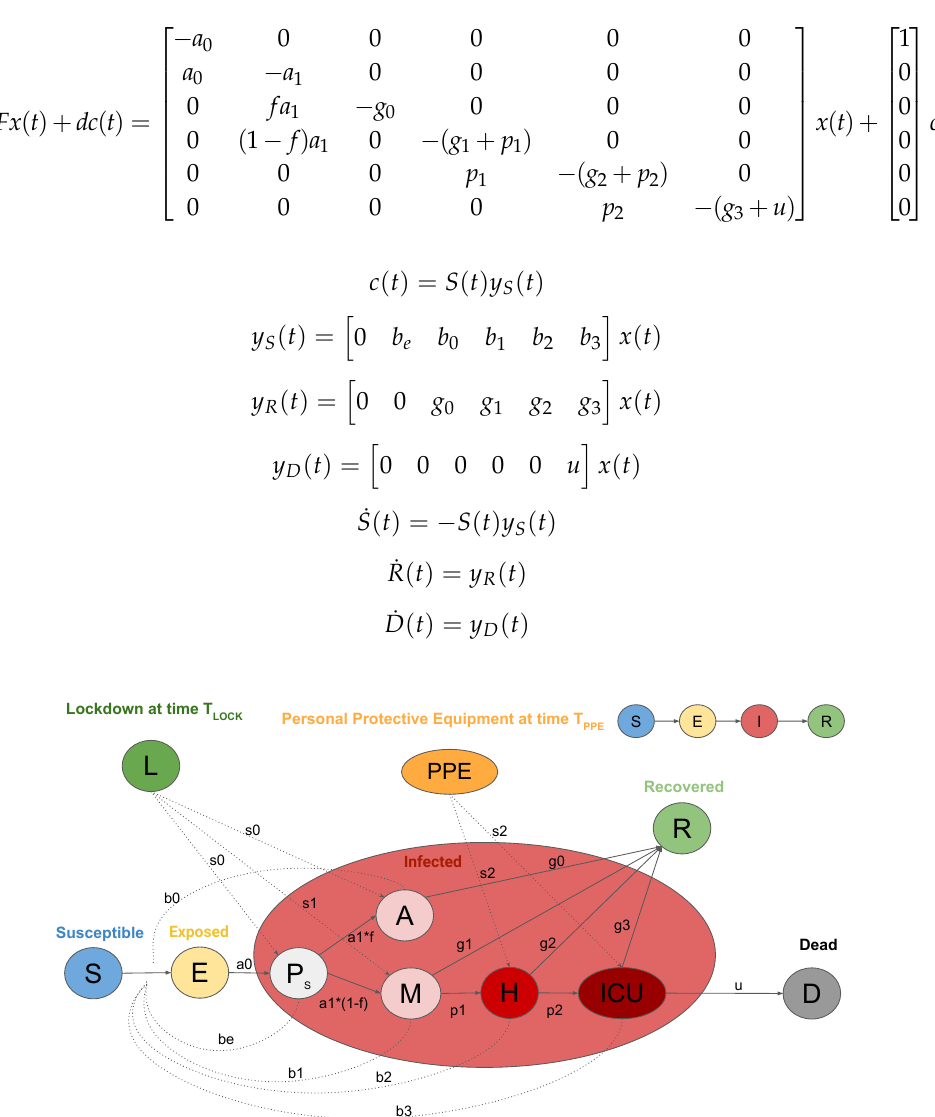
Figure 1. Graphic representation of the SEIRL model. Clinical stages of infection are: Susceptible ( S ), Exposed ( E ), Presymptomatic ( P S ), Asymptomatic ( A ), Recovered ( R ), Mild infection ( M ), Severe infection ( H ), Critical infection ( ICU ), and Dead ( D ). Control measures: Lock-down measures ( L ) and personal protective equipment ( PPE